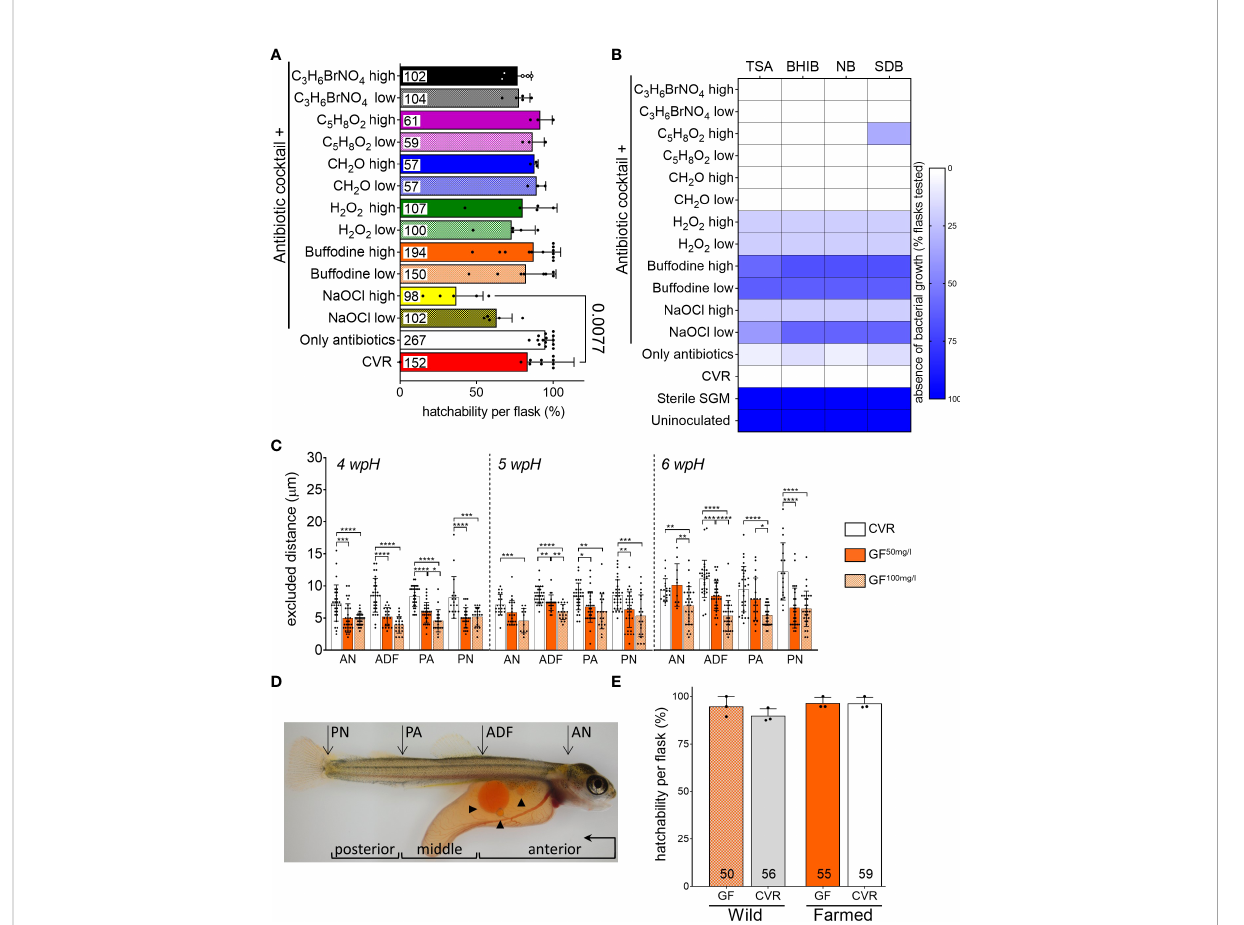
FIGURE 1 Effect of different derivation procedures on hatchability, microbial growth, and skin mucus layer of Atlantic salmon yolk sac fry (A) Hatchability per replicate fl ask two weeks after the expected hatching date (2 wpH), and after each derivation procedure. Chemical compounds used to disinfect eggs are designated by their molecular formula. Speci fi c concentrations labeled as high and low in the graph, as well as the composition of the antibiotic cocktail are speci fi ed in Supplementary Table 1. Data shown was pooled from three separate derivations, each with a different batch of eggs. Bar graphs represent mean hatchability per treatment ± SD and the total number of eggs is reported at the bottom of each bar. Means per treatment were compared to non-disinfected (conventionally raised, CVR) controls using Kruskal-Wallis and the post-hoc Dunn ’ s multiple comparison tests. (B) Heatmap representing the results of culture-based sterility tests using salmon gnotobiotic media (SGM) sampled from fl asks in (A) as inoculum. The color scale represents the percentage of replicate fl asks per treatment where microbial growth was absent. Number of fl asks per derivation procedure and culture media used are shown in Supplementary Table 2. Columns represent the culture media: TSA, tryptic soy agar; BHIB, brain heart infusion broth; NB, nutrient broth; and SDB, Saboraud-Dextrose broth. Samples were incubated aerobically at room temperature. SGM from CVR fl asks was used as positive control; uninoculated media and sterile SGM, as negative controls. (C) Estimated functional thickness of the mucus-like barrier at 4 wpH, 5 wpH, and 6 wpH. Excluded distance between skin epithelial surface and 1 µm particles was measured in CVR and germ-free (GF) fry obtained using two different derivation procedures: antibiotic cocktail plus iodine at 50 mg/l or 100 mg/l (GF 50mg/l and GF 100mg/l ). Measurements were taken at the four body sites: AN, anterior notochord; ADF, anterior to the dorsal fi n; PA, post-anal; and PN, posterior notochord. Bar graphs represent the mean excluded distance measured per bead ± SD. When possible, ten beads were measured per fry. Fry were raised in triplicate fl asks per condition. One fry was sampled from each replicate fl ask, thus a total of two to three fry per condition were measured. Means were compared to each other using one-way ANOVA and post-hoc Tukey ’ s multiple comparison tests. Because of the number of comparisons, p- values are designated with asterisks (* for p ≤ 0.05, ** for p ≤ 0.01, *** for p ≤ 0.001, and **** for p ≤ 0.0001). (D) Representative micrograph of a 6 wpH CVR fry. Body sites (AN, ADF, PA, and PN) where the excluded distance was measured are indicated with arrows. Arrowheads point to some of the multiple oil globules in the yolk. Body segments sectioned for histology analysis are indicated with brackets: anterior (from the snout to the anterior of the dorsal fi n), middle (from the anterior of the dorsal fi n to the anal pore), and posterior (from the anal pore to the posterior end of the notochord). The direction of sectioning is indicated in the anterior segment bracket. (E) Hatchability per replicate fl ask at 2 wpH after derivation of wild and farmed eggs. Bar graphs represent mean hatchability per treatment ± SD and the total number of eggs is reported at the bottom of each bar. Means were compared to each other using Kruskal-Wallis and post-hoc Dunn ’ s multiple comparison